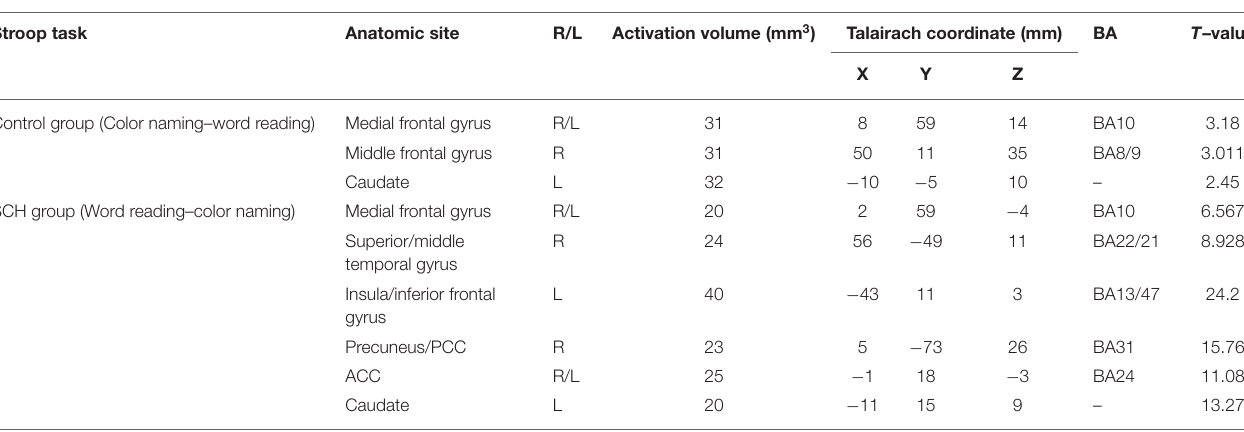
TABLE 5 | Brain activation differences during the Stroop task in both